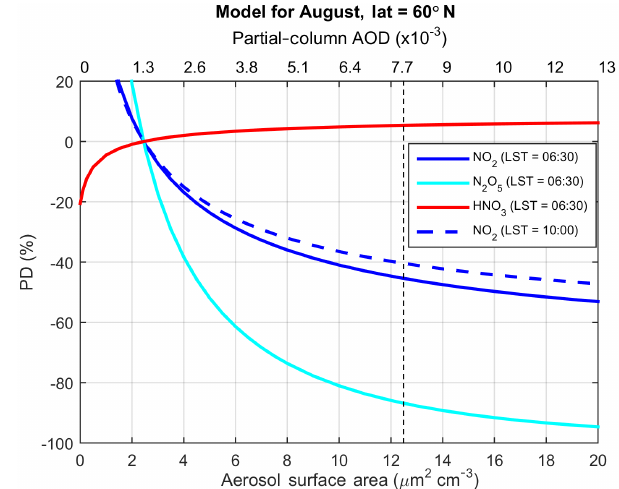
Figure 2. Modeled variations in NO 2 , N 2 O 5 , and HNO 3 with stratospheric aerosol at 60 ◦ N in August. The aerosol surface area (bottom x axis) and partial-column AOD (top x axis) are both shown. The y axis gives the percent difference (anomaly and back- ground) for partial VCDs of NO 2 (blue line), N 2 O 5 (cyan line), and HNO 3 (red line) at the approximate OSIRIS local time (06:30LT) and for NO 2 (blue dashed line) at the approximate MIPAS mea- surement time (10:00LT). AODs and VCDs were calculated for a 5km layer starting ∼ 3km above the tropopause. The black dashed line indicates a partial-column AOD = 8 × 10 − 3 , approximately the largest value in the OSIRIS